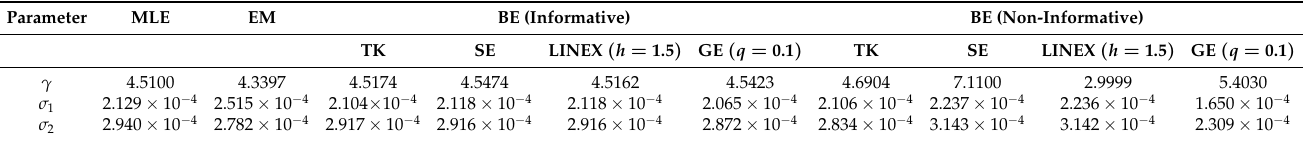
Table 3. MLEs and BEs for the parameters of EED for application